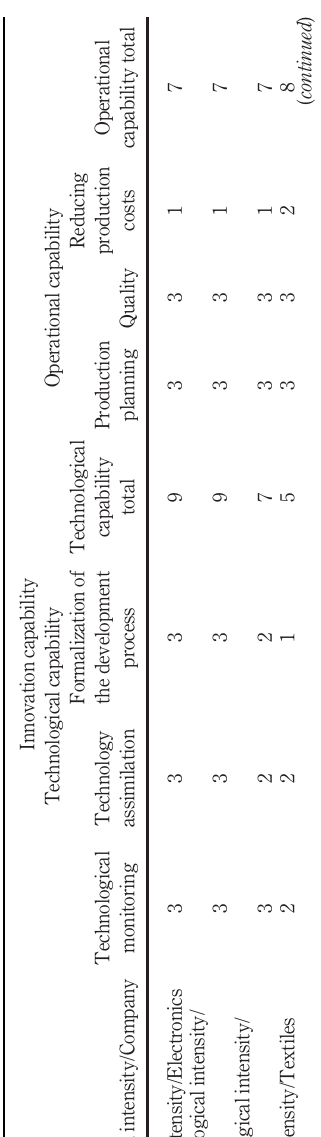
Table IV. Levels of technological intensity and innovation capability of four firms in Rio Grande Do Sul -